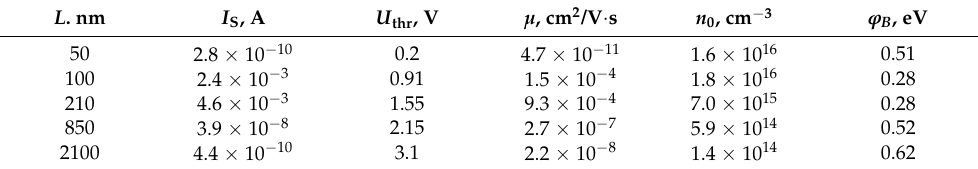
Table 2. Parameters of co-PAEK films depending on the thickness L . Here, I S is the saturation current, U thr is the threshold voltage for the transition to the super-linear regime, µ is the charge carrier mobility, n 0 is the charge carriers concentration, and ϕ B is the potential barrier height at the ITO/polymer